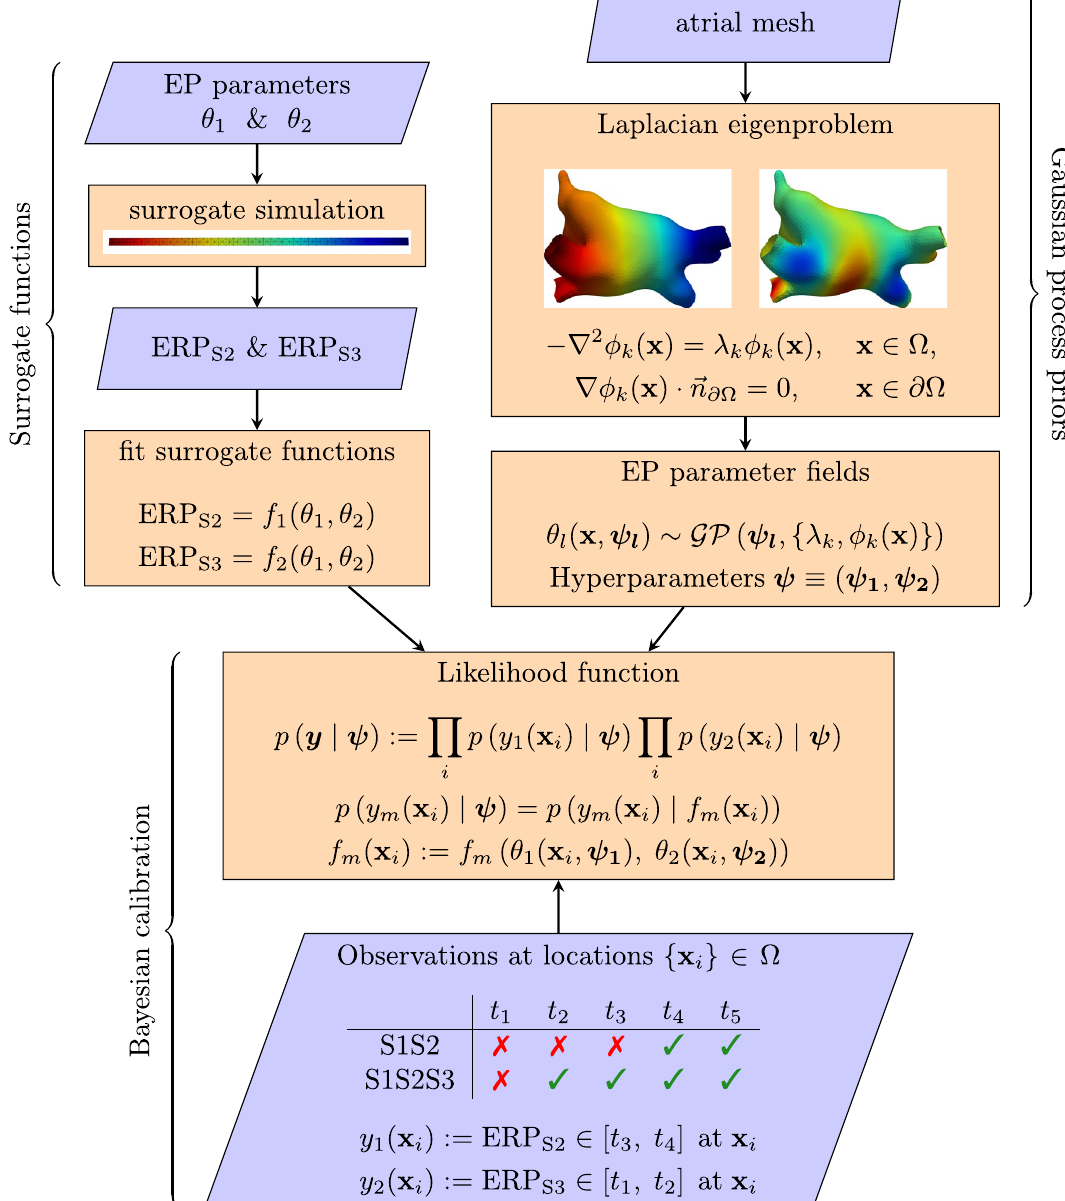
Figure 1. Workflow for using ERP observations to calibrate model parameters. A simplified ‘surrogate simulation’ consisting of a strip of tissue paced from one end is used to determine ERP values for a design of parameters. Surrogate functions are fit to these data, allowing rapid prediction of ERP from model parameters. Electrophysiology parameter fields are modelled as Gaussian processes on the atrial manifold, using a reduced- rank formulation relying on eigenfunctions and eigenvalues of the Laplace-Beltrami operator on the atrial mesh. ERP measurements using an S1S2 (or S1S2S3) protocol measure whether successful activation occurs for S2 (or S3) times t 1 < t 2 < t 3 . . . etc. Using a likelihood function designed for ERP measurements and